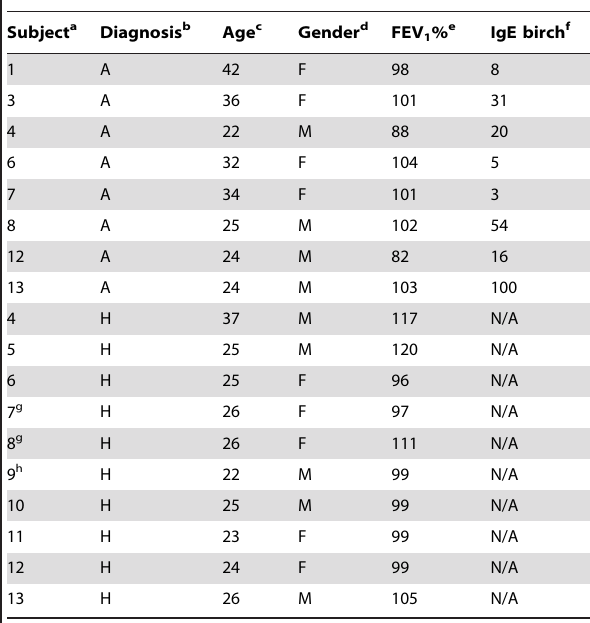
Table 1. Clinical data of participating